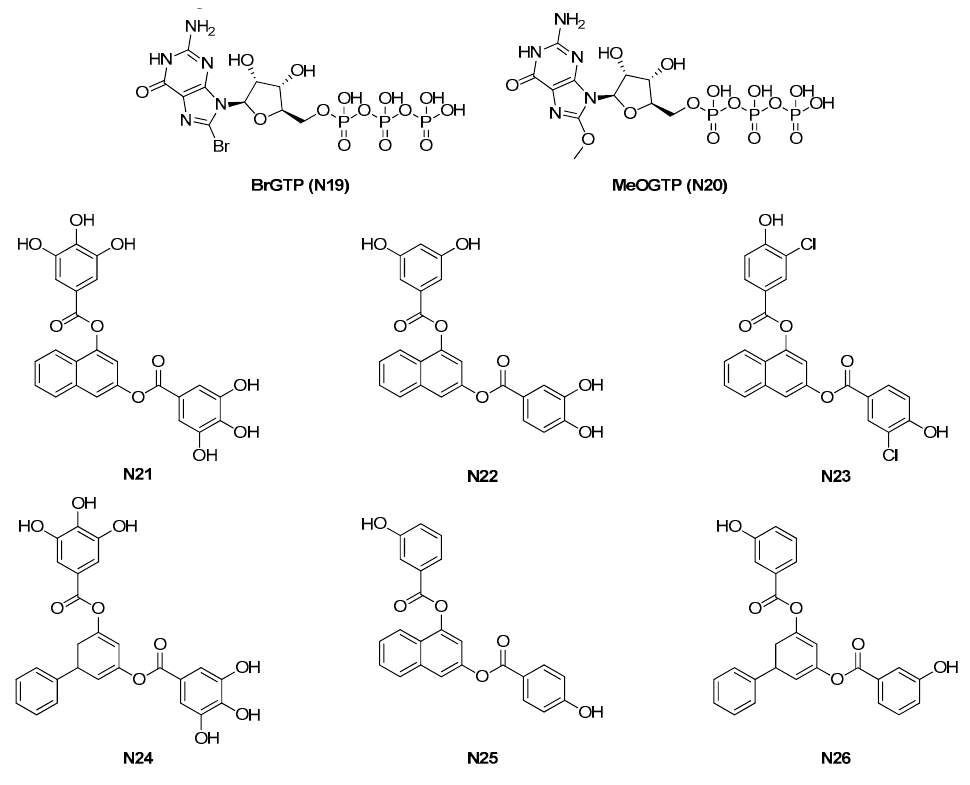
Table 5. MICs of non-nucleotide GTP analogues N21–N26.